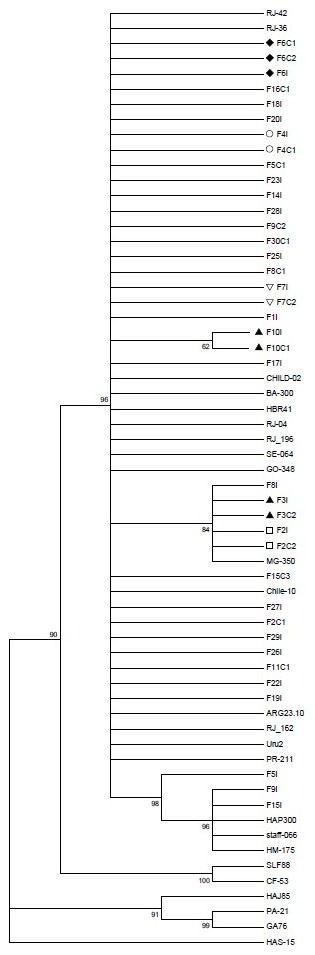
Phylogenetic analysis of 39 HAV isolates based on 168 nucleotides of VP1/2A (position 3024–3191), constructed by the method of Maximum Likelihood.The value of bootstrap was calculated from 2,000 replicates. Strains marked by symbols refer to families who had isolates with high nucleotide identity.